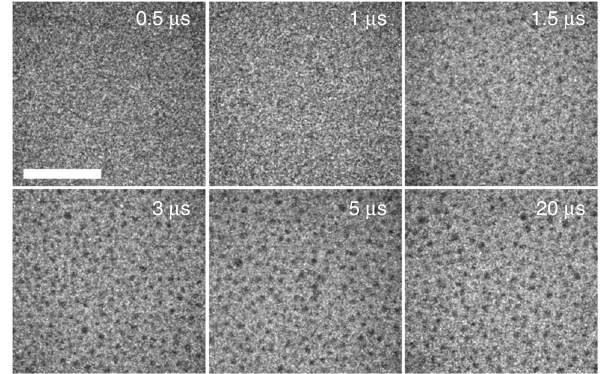
Fig. 5 Time-resolved imaging. Single-shot TEM images in plan-view diffraction contrast at different delays (top right in each image). Only the Ni particles after the reduction are visible. Scale bar: 1 µ